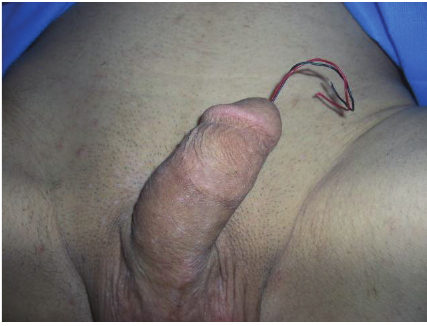
Figure 1: The wire ends are extruded from the external meatus. Figure 2: Pelvic X ray: the intravesical wire is evident.